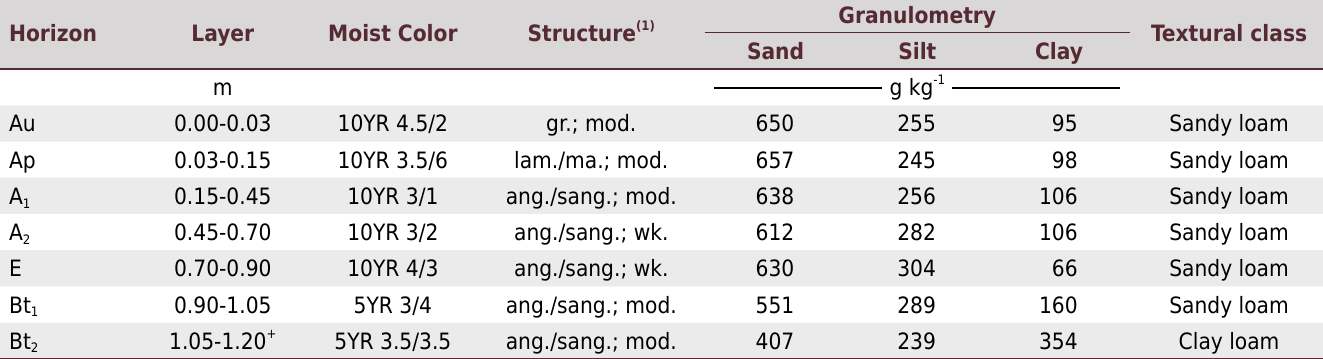
Table 1. Characterization of the Abruptic Alisol of the experimental site Horizon Layer